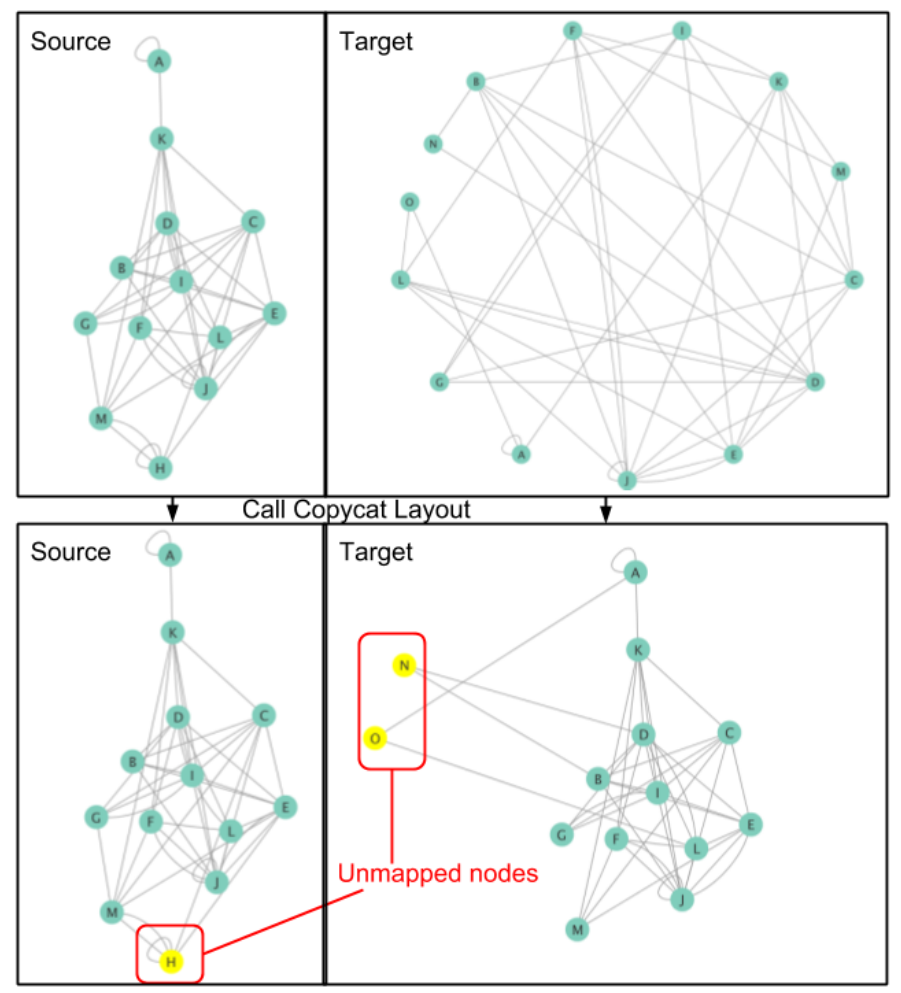
Figure 2. Calling Copycat layout on a derived subnetwork with the selectUnmapped parameter set to false. After the Copycat layout, the target network nodes have the same coordinates as the corresponding source network nodes. Because the node H in the source and nodes N and O in the target are unmatched, they are